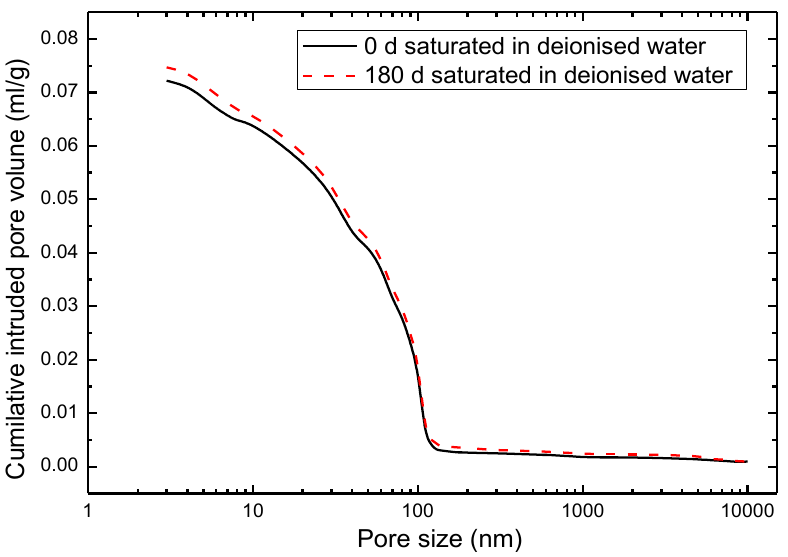
Figure 1. The cumulative intruded pore volume vs. pore diameter curves for ordinary Portland